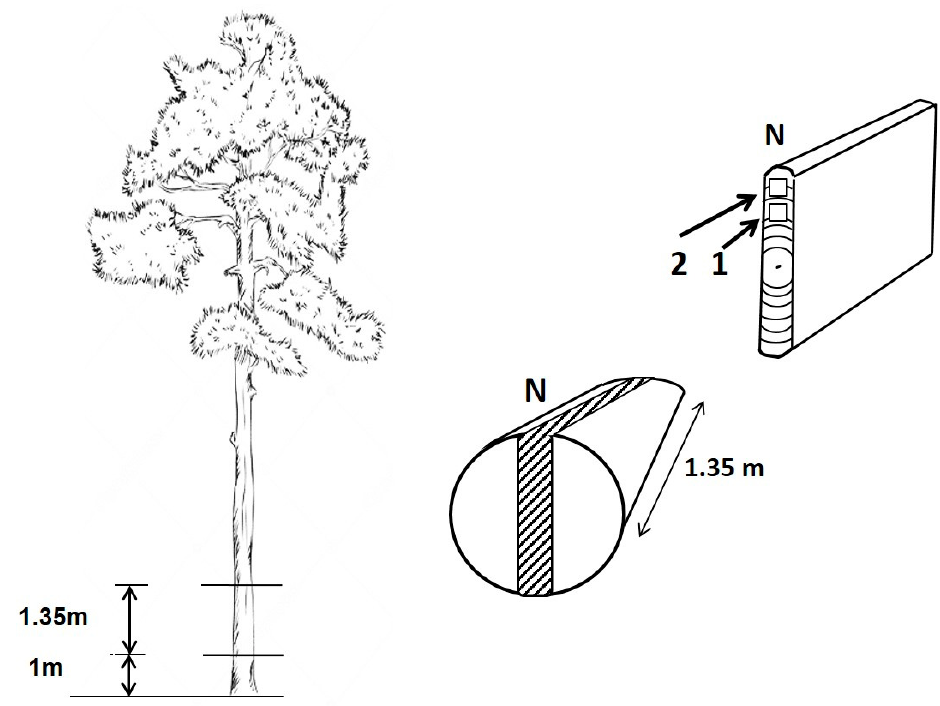
Figure 2. A diagram showing the process of collecting material for calculating the relative wood density. The numbers 1 and 2 show the places where the samples for the analysis were taken from.